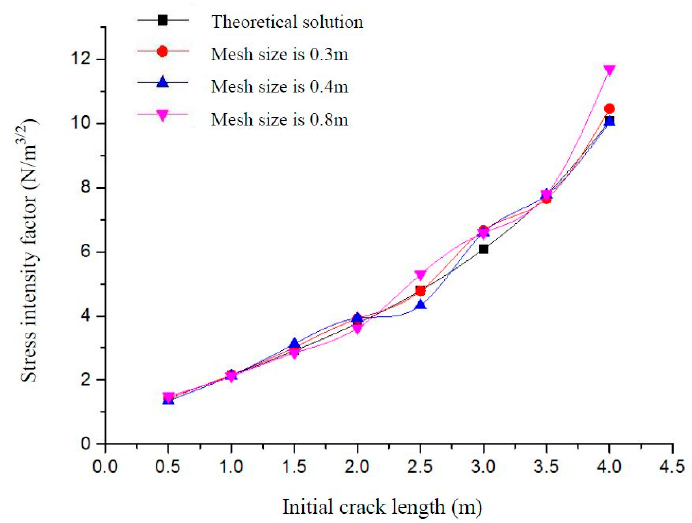
Figure 5. Stress intensity factors for different initial crack lengths and mesh densities.